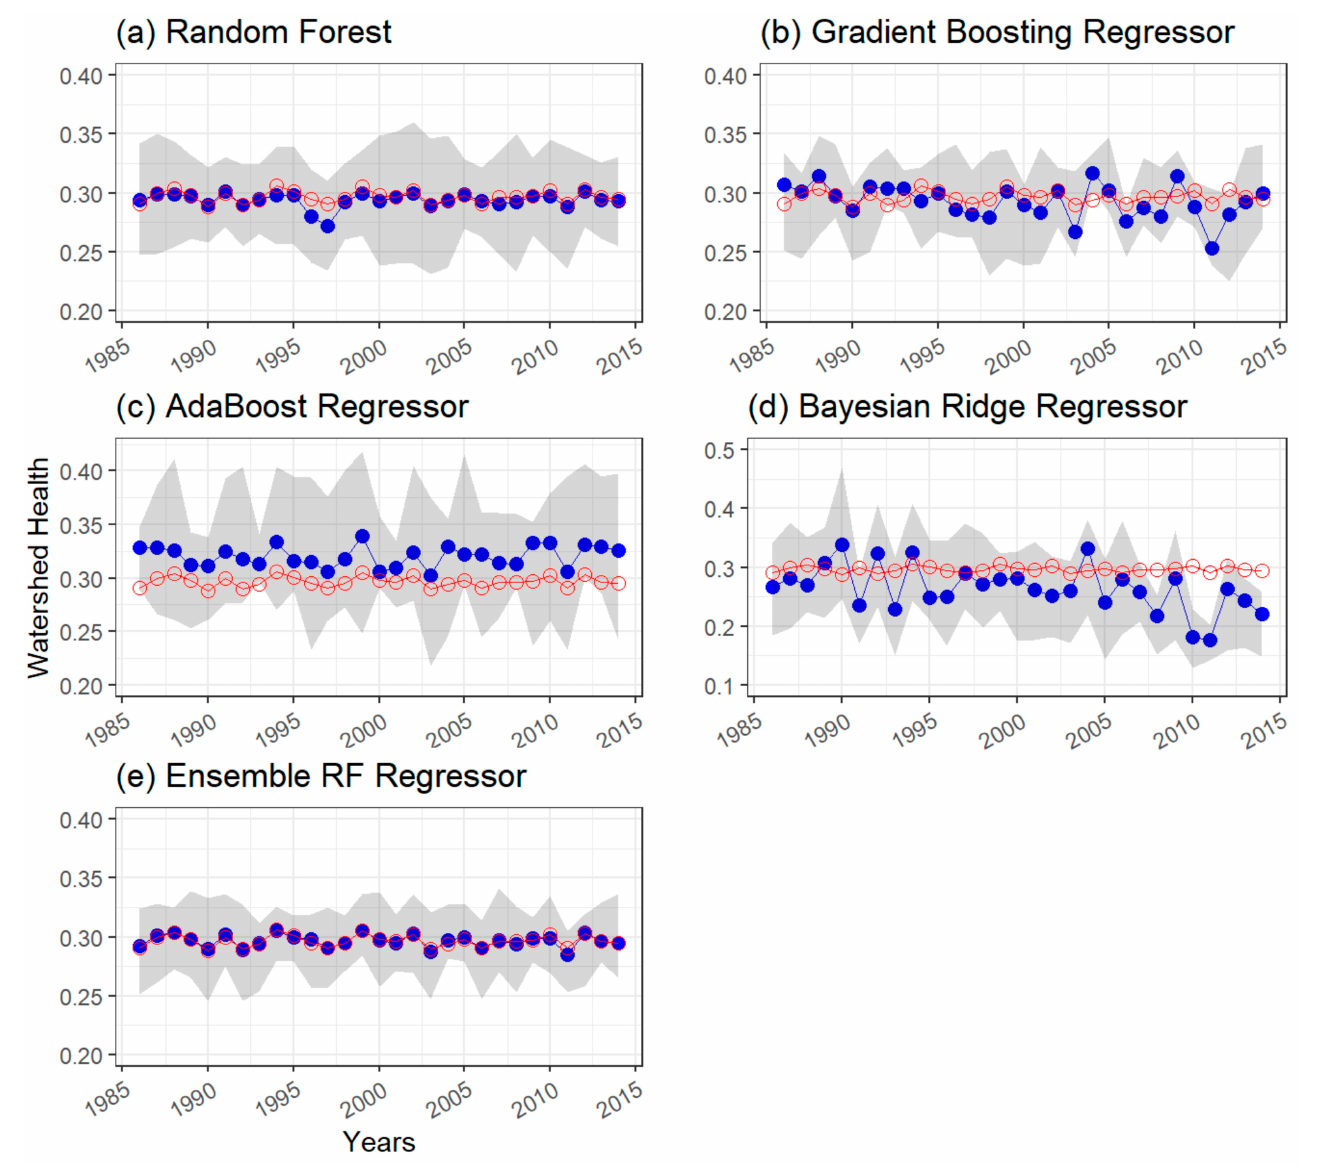
Figure 5. Time series comparison of watershed health (with respect to SSC) estimated from observations as in Mallya et al. [48] at USGS-NAWQA station 04193500 Maumee River at Waterville, OH, which was part of the test set versus ML model predictions using ( a ) random forest regressor, ( b ) gradient boosting regressor, ( c ) AdaBoost regressor, ( d ) Bayesian ridge regressor, and ( e ) ensemble RF regressor. Only values for the period 1986–2014 are shown for brevity. Red-line plot with red-colored hollow circular markers indicates reference WH values. Blue-line plot with solid blue-color circular markers indicates predictions from ML models. The shaded-grey region represents 90 percent prediction interval for the ML